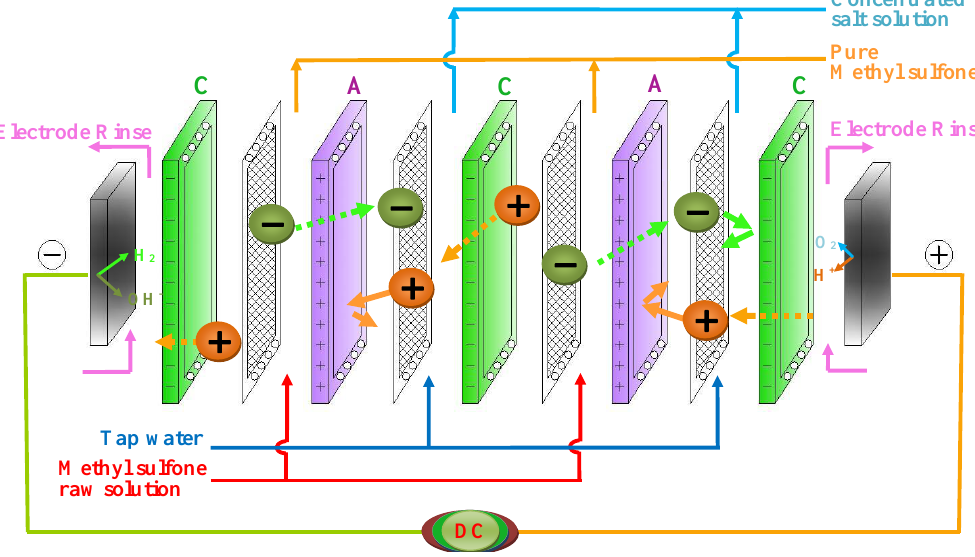
Figure 1. Schematic diagram for the purification of methylsulfonylmethane (MSM) by electrodialysis.